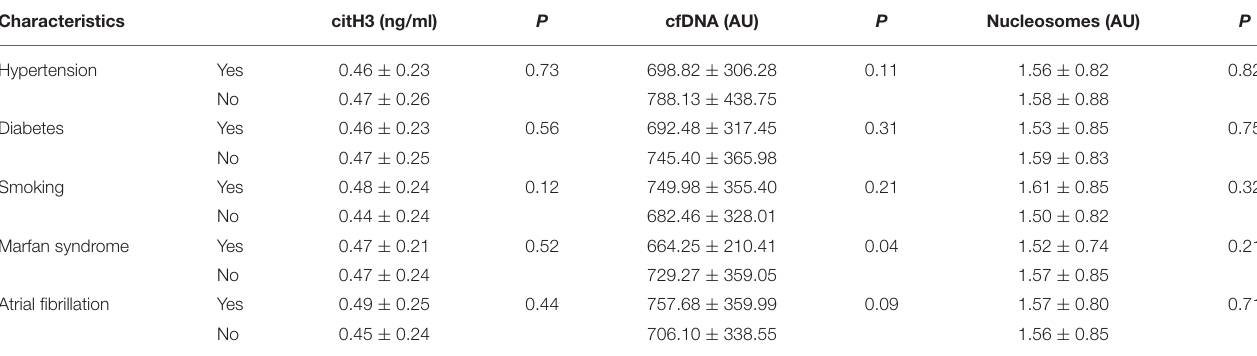
TABLE 2 | NETs and risk factors before the onset of the acute event.